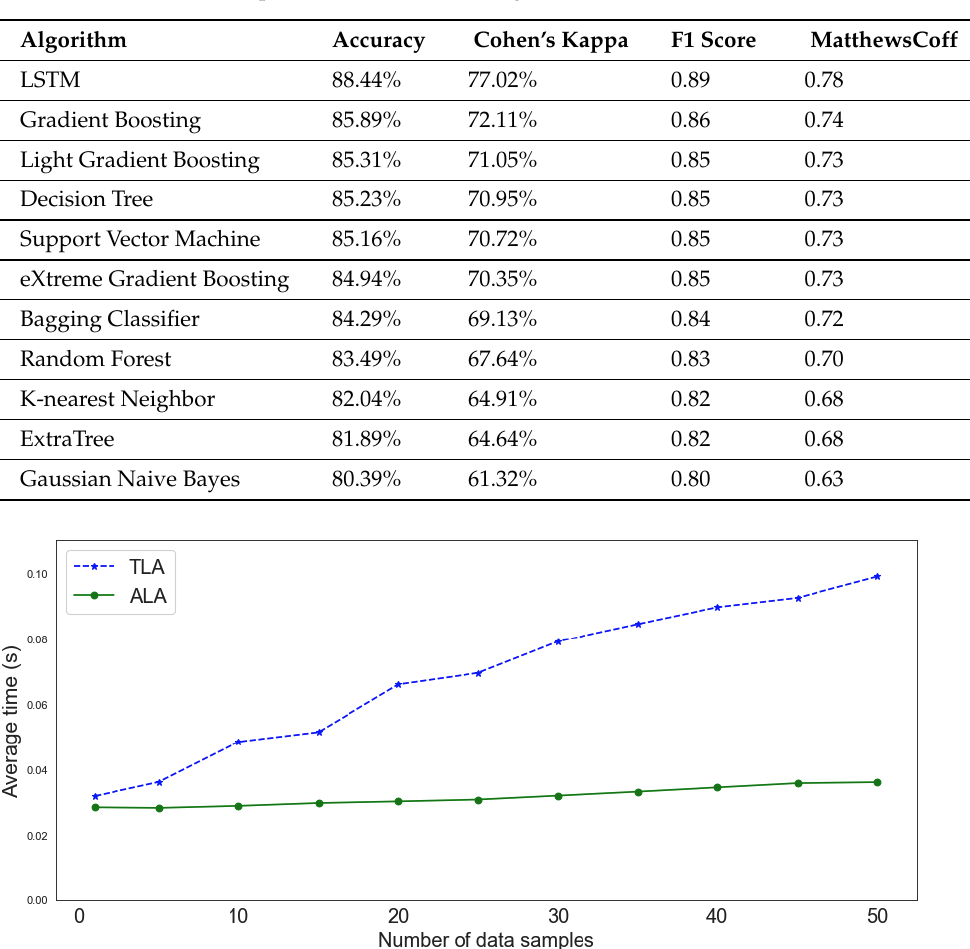
Table 1. The classification performance of the ML algorithms.